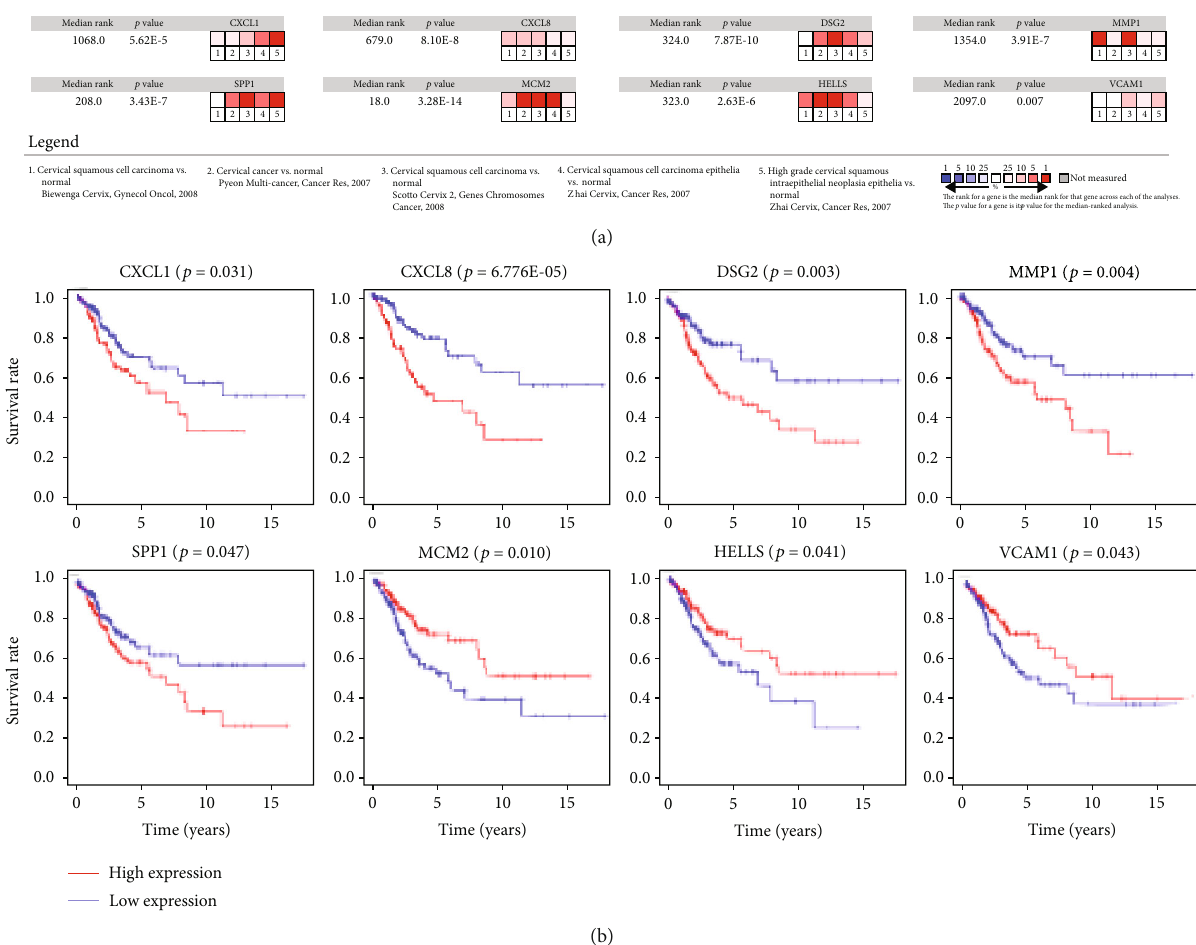
Figure 4: In-depth screening for hub DEGs in CC. (a) mRNA expression levels of candidate hub DEGs evaluated using the Oncomine microarray database. (b) Kaplan-Meier survival analysis and the log-rank test. The mRNA levels of CXCL1 ( p = 0 : 031 ), CXCL8 ( p < 0 : 001 ), DSG2 ( p = 0 : 003 ), MMP1 ( p = 0 : 004 ), SPP1 ( p = 0 : 047 ), MCM2 ( p = 0 : 010 ), HELLS ( p = 0 : 041 ), and VCAM1 ( p = 0 : 043 ) were signi fi cantly associated with OS among CC patients. CC: cervical cancer; DEG: di ff erentially expressed gene; OS: overall